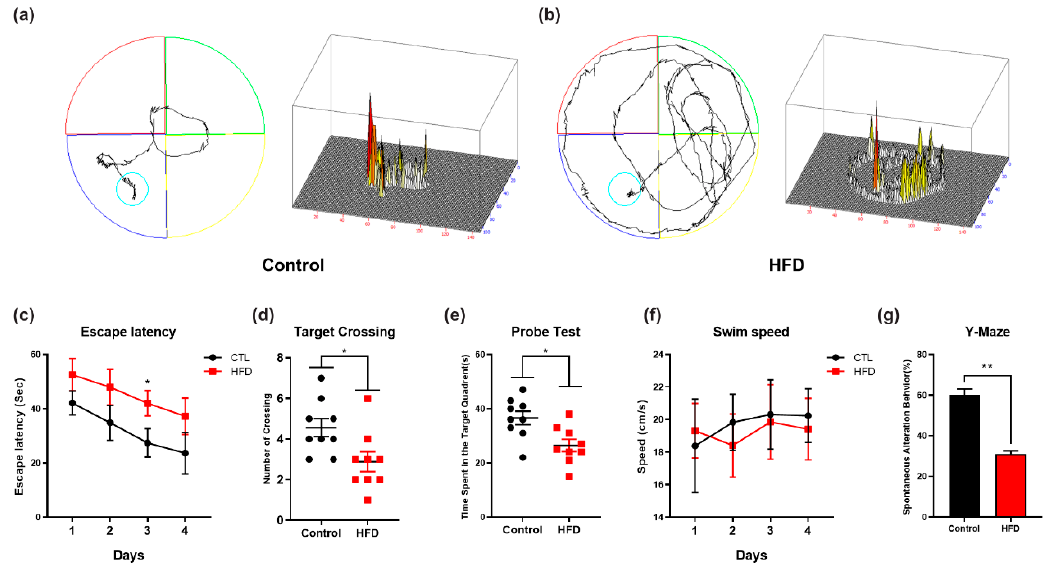
Figure 7. E ff ect of HFD on spatial learning, memory, and cognitive impairment ( a , b ) Representative maps indicates trajectories path lengths covered by the mice during probe test, in the Morris water maze (MWM) test ( c ) Mean escape latency (sec) indicated by line graph to reach the hidden platform during the training sessions, in the MWM test ( d , e ) Target crossing or number of platform crossing and time spent in the target quadrant during the probe test, in the MWM test ( f ) Line graph representing swimming speed (cm / s) of the mice during their search for the hidden platform during the training sessions before the probe test. To calculate swimming speed (cm / s), we used the equation v = distance / time. No significant di ff erence was observed between the swimming speeds of the experimental groups. ( g ) The histogram analysis of percentage spontaneous alternation in the Y-Maze test, * p < 0.05, using Student’s t -test against their respective normal chow diet control. Significance = * p < 0.05, ** p < 0.01.